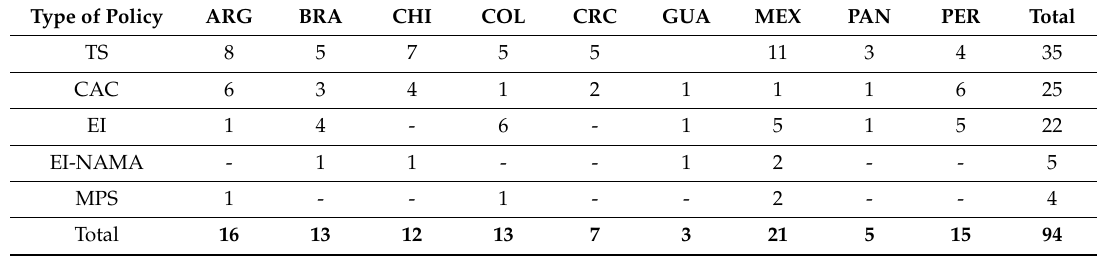
Table 2. Total policies found by type and country. Countries are represented by three-letter equivalents per the list in Section 1.2.